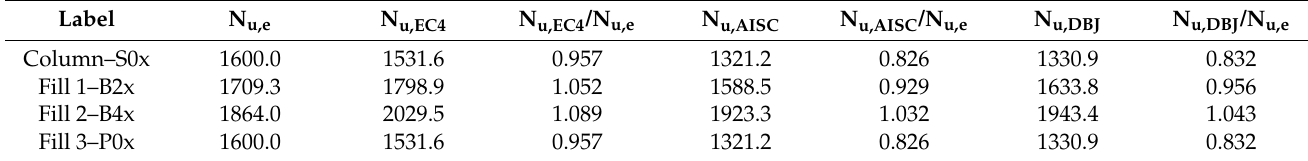
Table 5. Comparison between calculated member bearing capacities and test